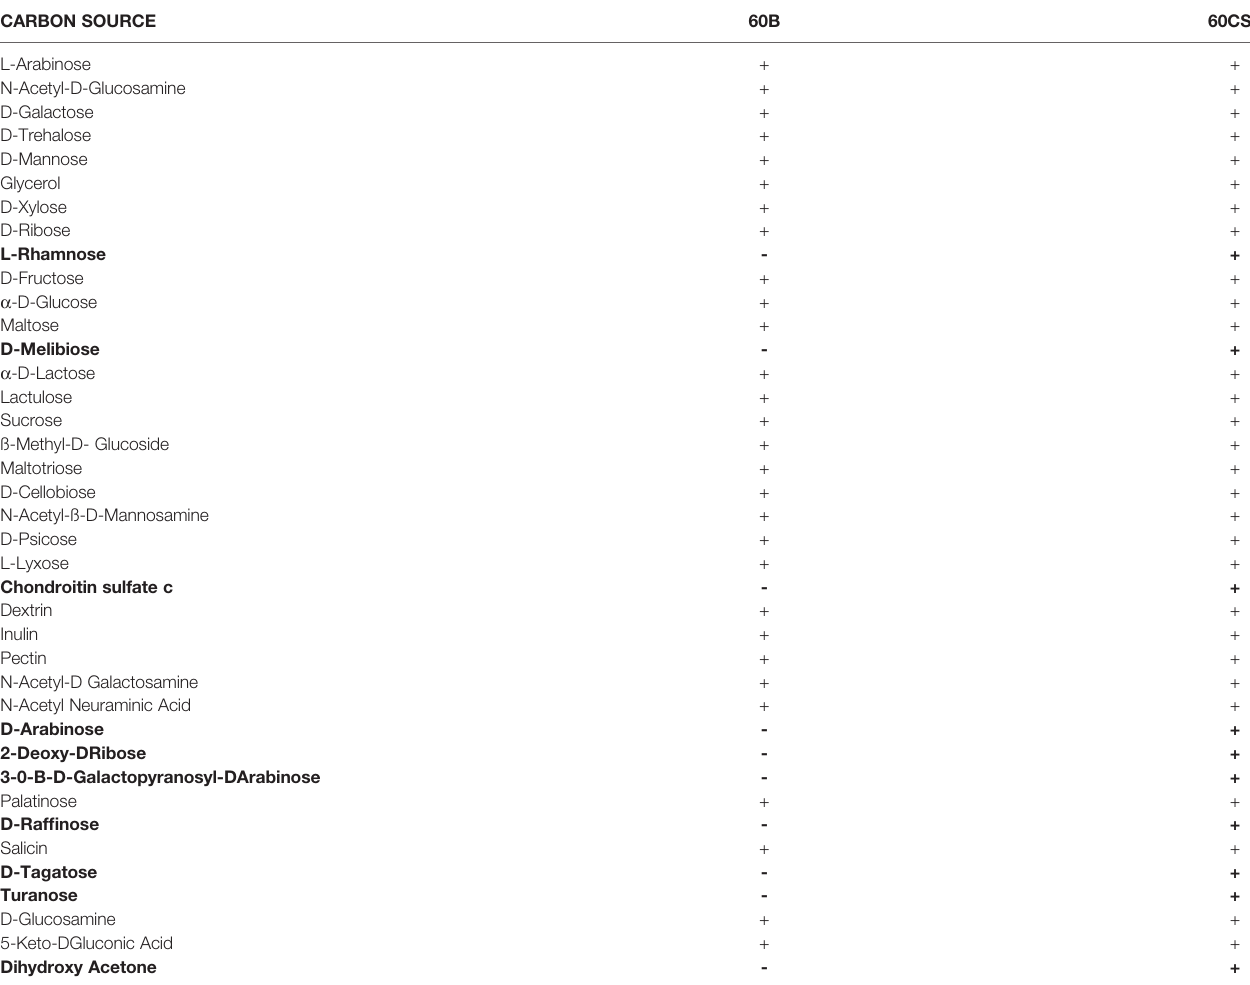
TABLE 3 | Phenotype microarray results for 60B and 60CSF in Biolog PM1 and PM2a plates. CARBON